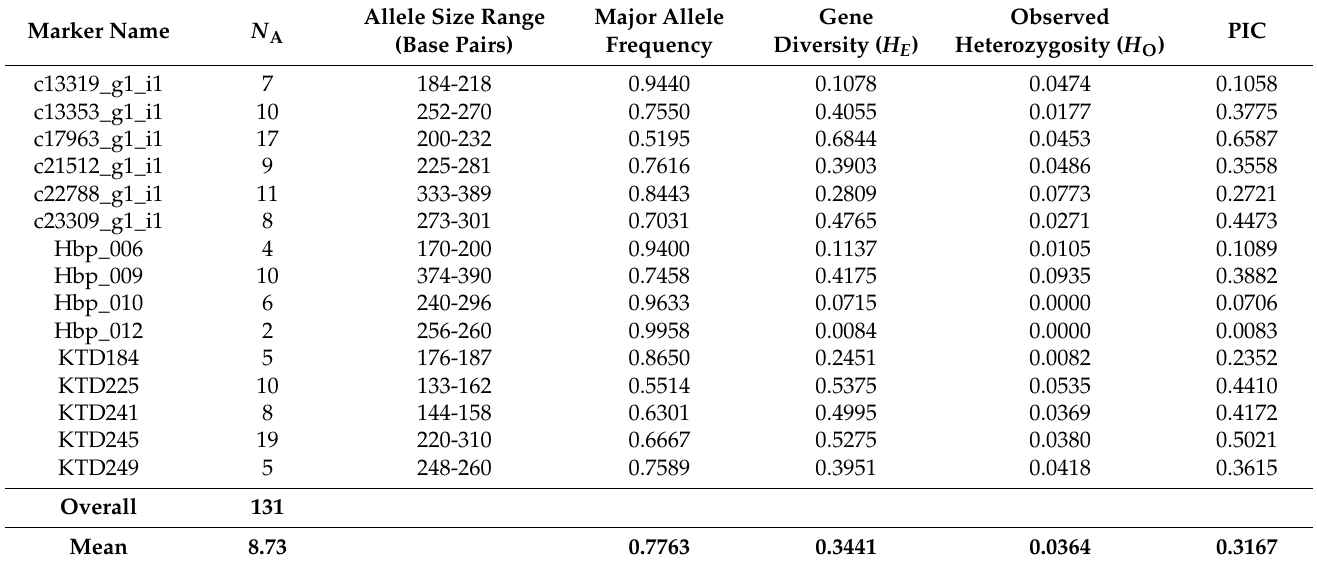
Table 2. Number of alleles per locus ( N A ), allele size range, major allele frequency, and polymorphic information content (PIC) of 15 nuclear polymorphic SSR markers in 493 lablab